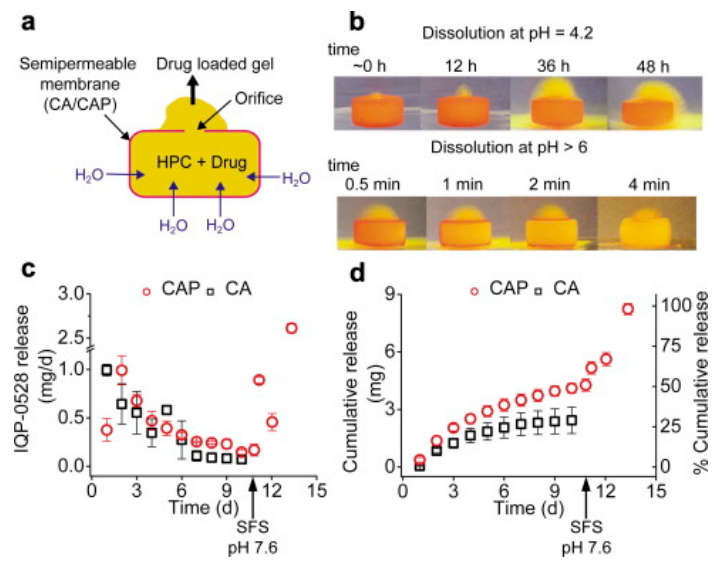
Figure 11. In vitro IQP-0528 release from osmotic pump tablet (OPT). ( a ) Diagram showing working of an OPT. Water is driven through the semipermeable membrane (cellulose acetate (CA)/cellulose acetate phthalate (CAP)) into the core (HPC + Drug) due to osmotic pressure difference, causing polymer swelling and extrusion of a drug loaded gel though the orifice. ( b ) Photograph showing a dye loaded CAP-OPT in release media at pH 4.2 (upper panel) and >6 (lower panel). Extrusion of a dye-loaded gel can be seen within the first hour. Upon increase in pH > 6, the CAP coating was instantaneously seen to dissolve leaving a gelled core. ( c ) Daily and ( d ) cumulative release of IQP-0528 from CAP- and CA-OPT in 25 mM acetate buffer pH 4.2 (simulated vaginal conditions) followed by mimicking pH increase by changing release media to seminal fluid simulant (SFS) pH 7.6 (N = 3; Mean ± SD). Adapted from “Osmotic pump tablets for delivery of antiretrovirals to the vaginal mucosa” by Rastogi et al.